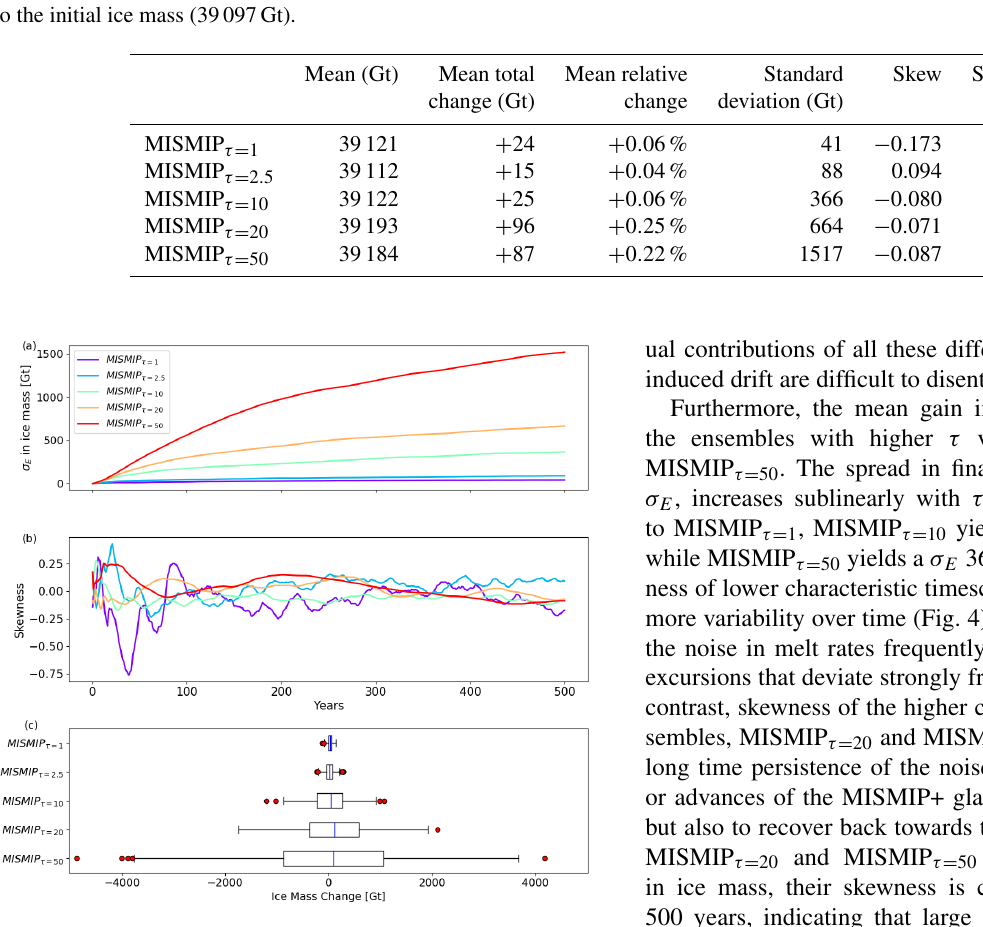
Figure 4. Evolution throughout the transient experiments of (a) the standard deviation and (b) the skewness in total ice mass for the five MISMIP+ transient ensembles. (c) Boxplots of the final ice mass distributions. Red dots indicate ice masses beyond 1.5 times the in- terquartile range from the